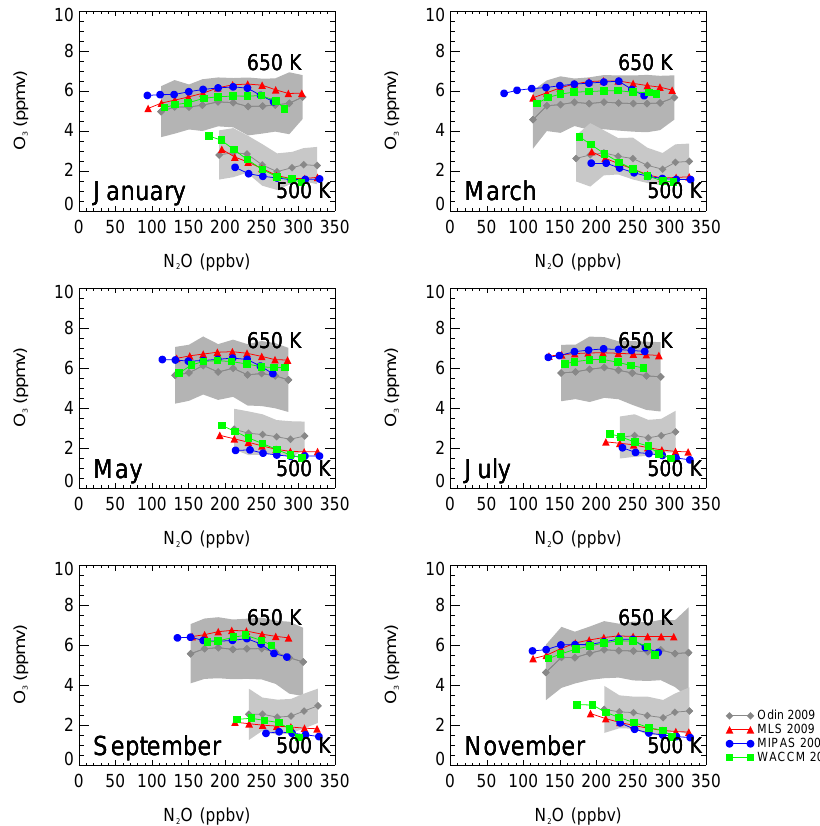
Fig. 13. Same as Fig. 11, but for the year 2009 and including Aura/MLS and SD-WACCM data. Odin/SMR (grey diamonds), Aura/MLS (red triangles) and SD-WACCM (green squares).